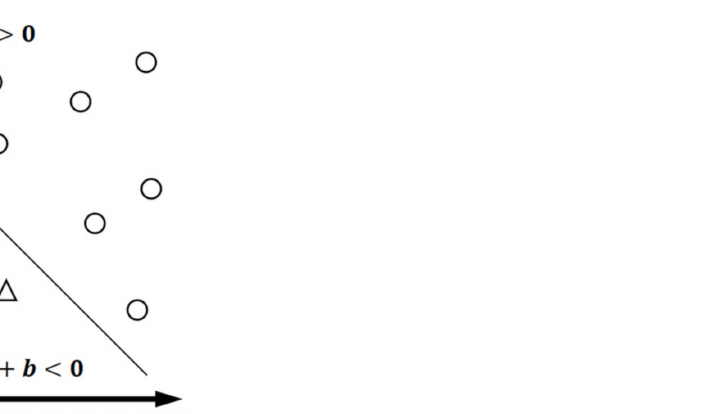
Figure 2. Visualization of the hyperplane separating the two types of vectors (assuming g ( x ) = 0). In this study, the radial basis function (RBF) was selected as the kernel function, Gamma = 1, and the system default values were used for other parameters when SVM was used to establish the mangrove forests distribution model in the Hainan